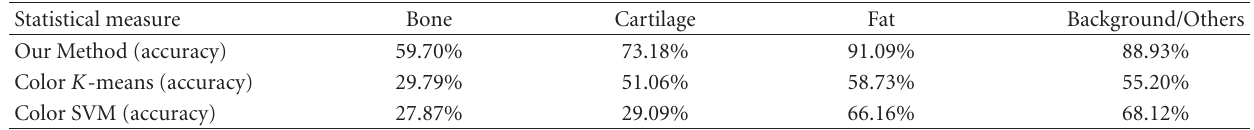
Figure 5: Segmentation of tissues for images of teratoma histology: (a) original image, (b) our result, (c) color K -means’ result, (d) color SVM’s result, (e) ground truth. Table 3: Quantitative evaluation for images of teratoma